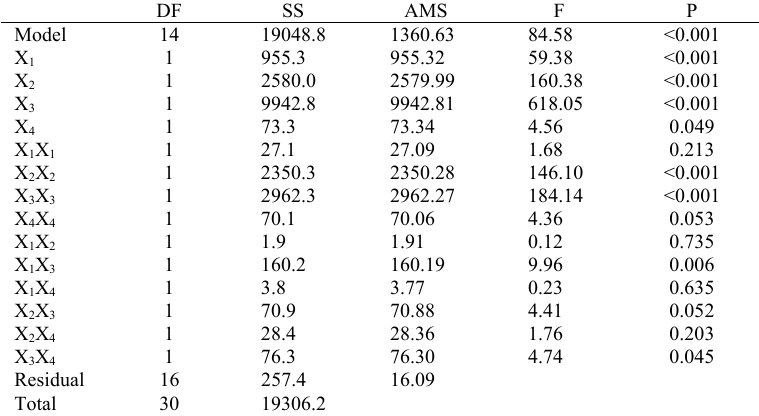
Table 3: ANOVA table for response surface quadratic model